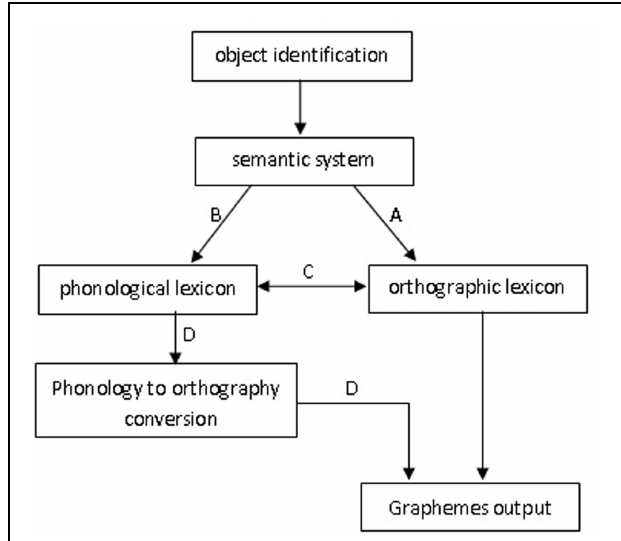
FIGURE 1 | Sketch model of written picture naming (Bonin et al., 2001).